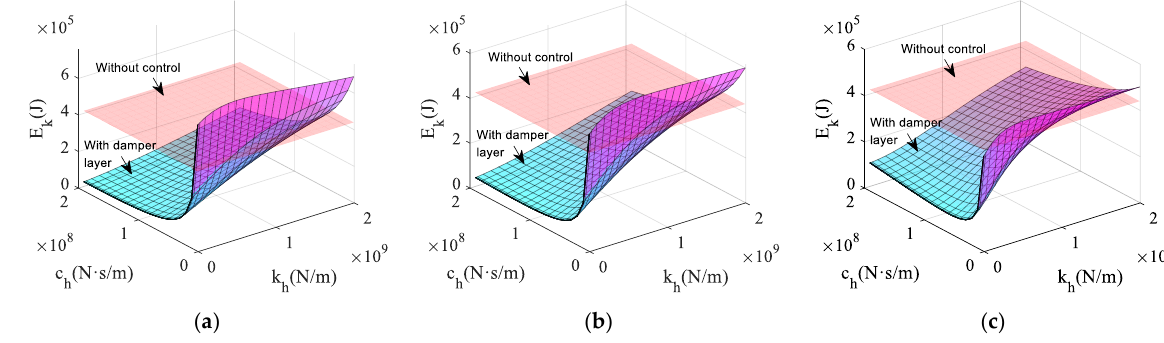
Figure 7. The mean kinetic energy versus the parameters and position of the damping layer (model 3): ( a ) the damping layer is located at the 3rd floor; ( b ) the damping layer is located at the 9th floor; ( c ) the damping layer is located at the 15th floor.